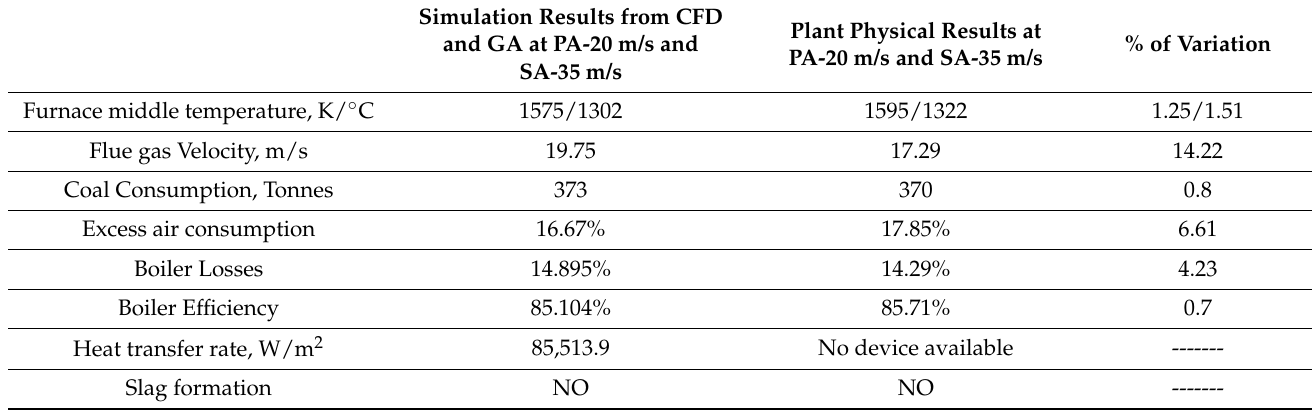
Table 13. Simulation results in comparison with experimental results from the plant. Simulation Results from